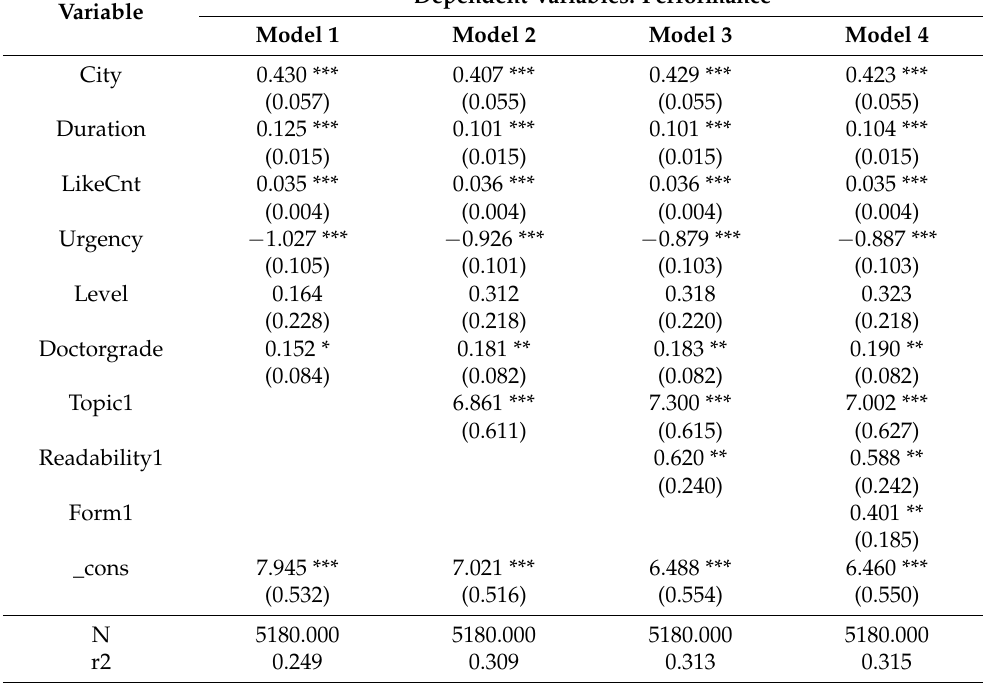
Table 7. Regression